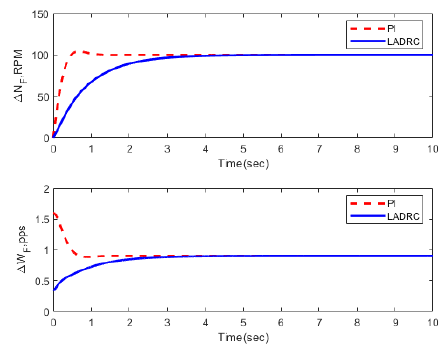
Figure 12. Step response of FC03.